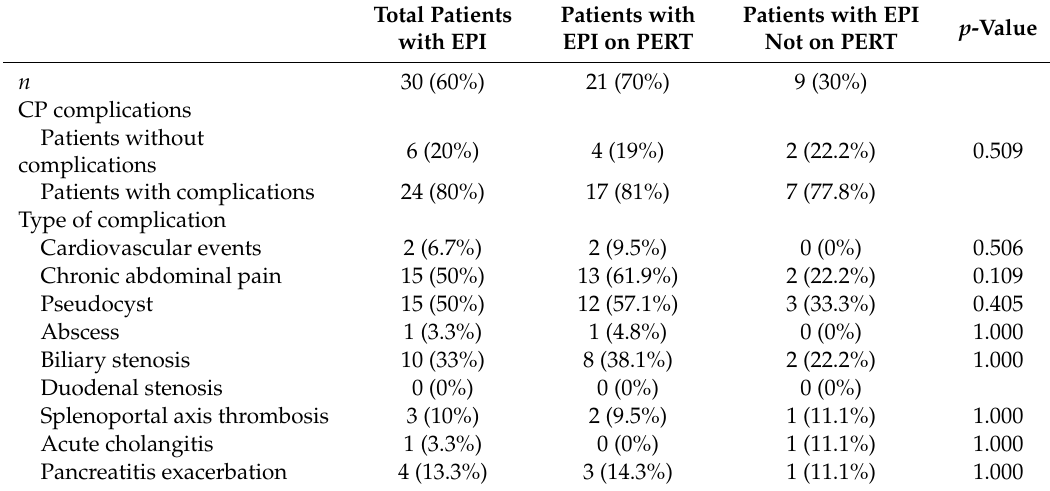
Table 6. Complications of chronic pancreatitis in patients with EPI on PERT and not on PERT. Total Patients with